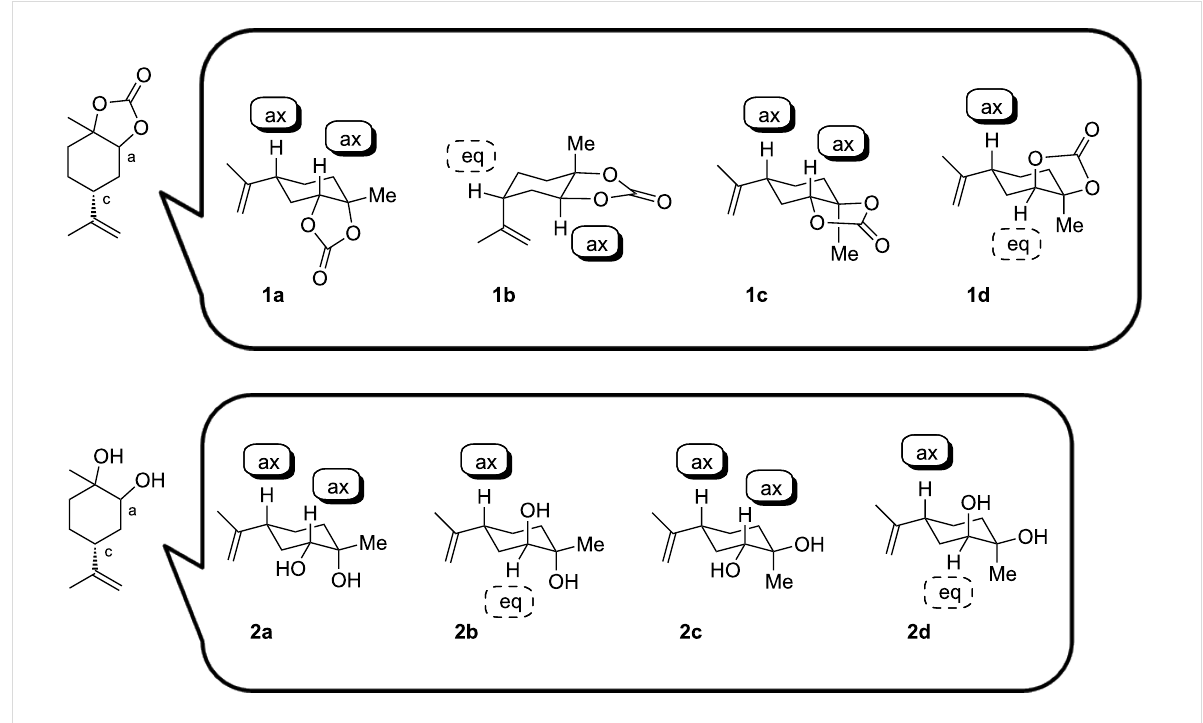
Figure 5: Plausible conformations of LM5CCs and LMdiols in CDCl 3